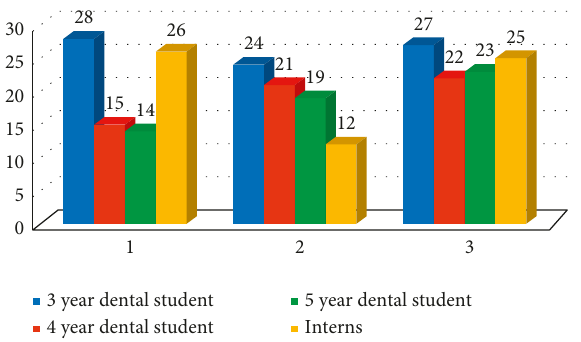
Figure 2: Awareness of participants if ultrasound and MRI involve ionizing radiation ( χ 2